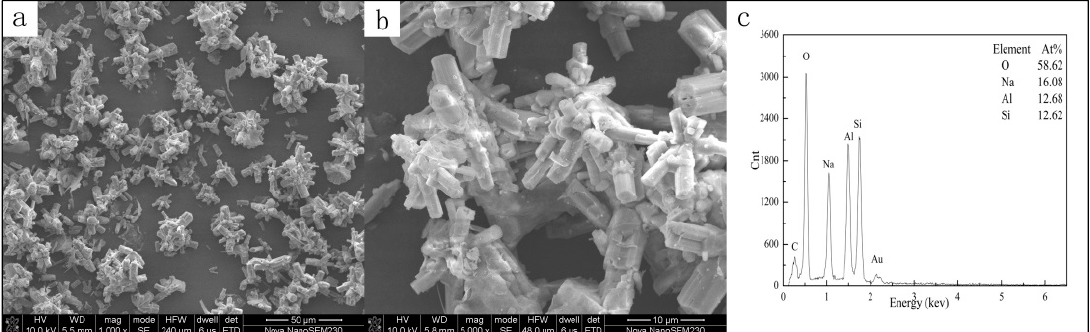
Figure 7. SEM-EDS analysis of alkali leached residue: ( a ) Magnification is 1000 times and scale bar is 50 μ m; ( b ) Magnification is 8000 times and scale bar is 5 μ m; ( c ) EDS (Experiment condition: alkali